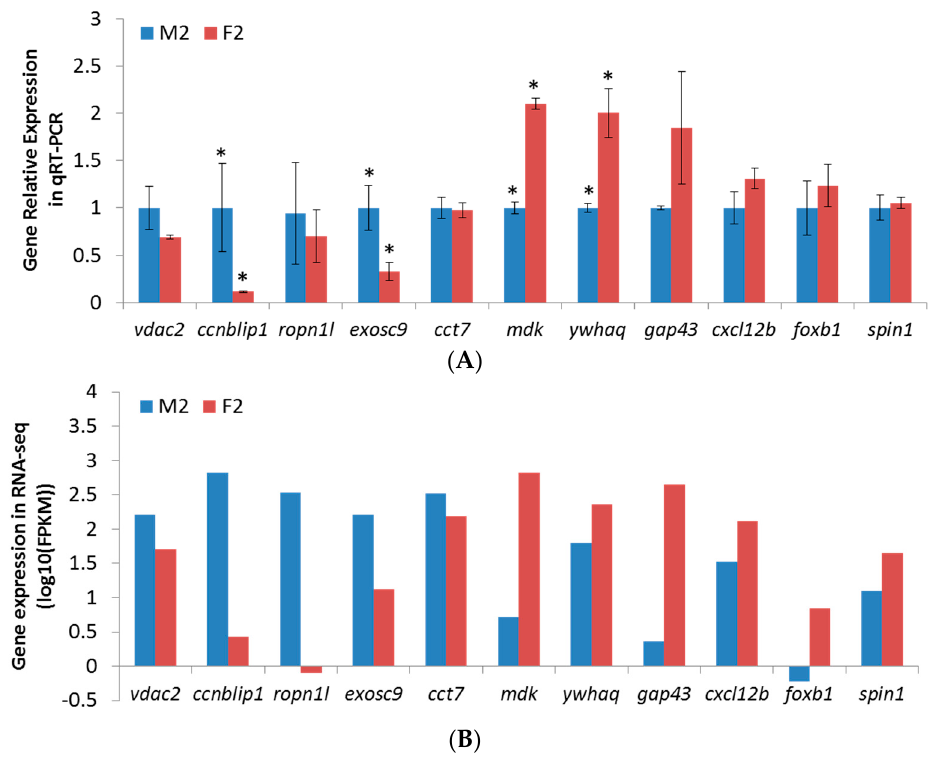
Figure 3. Brain transcriptome validation by qPCR using eleven selected genes: ( A ) Gene relative expression in qPCR where Error bars represent standard deviation of technical replicates and the expression differences between M2 and F2 were tested by two-tailed Student’s t -test, with 95% confidence level ( p < 0.05) being labeled with an asterisk; and ( B ) gene expression in RNA-Seq.